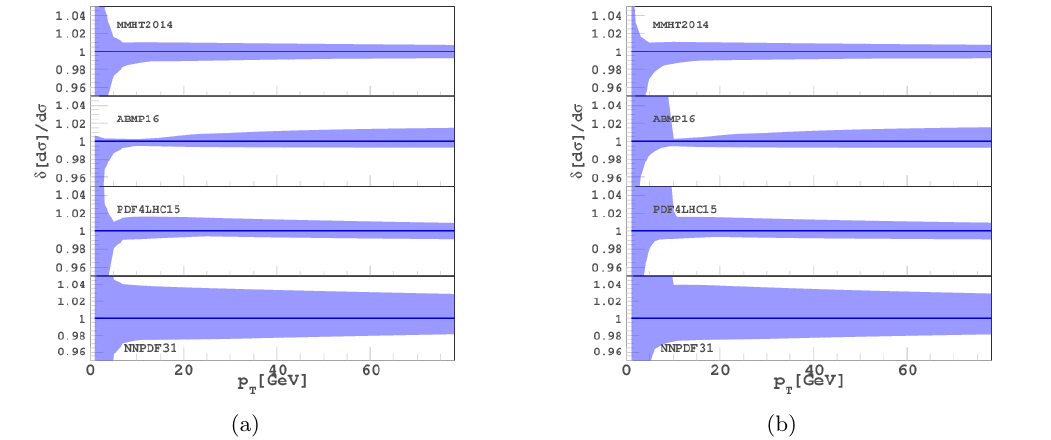
Figure 7 . PDF variation at NNLO A +NNLL for (a) 14 TeV and (b) 13 TeV using various sets. The y-axis represents the ratio of extremum variation over the central PDF set.